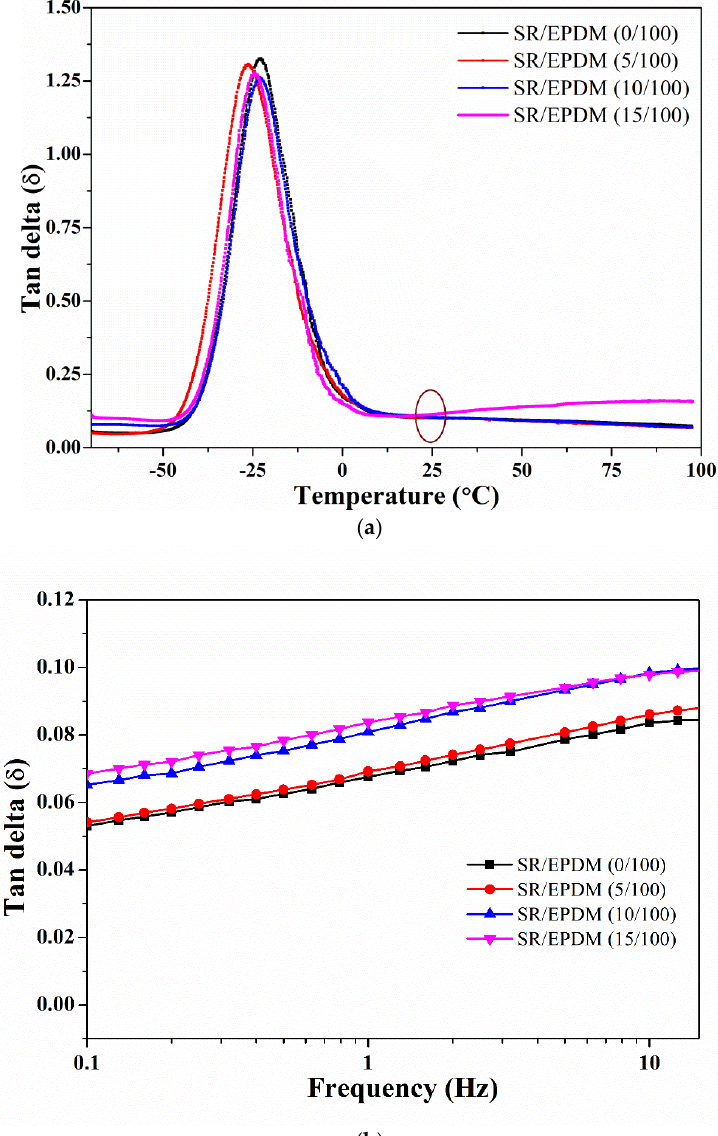
Figure 5. ( a ) Temperature dependence of tan δ and ( b ) variation of tan δ with dynamic frequency sweep for SR/EPDM composites.